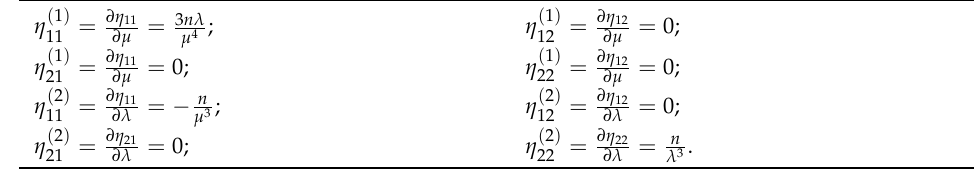
Table A2. The entries of η